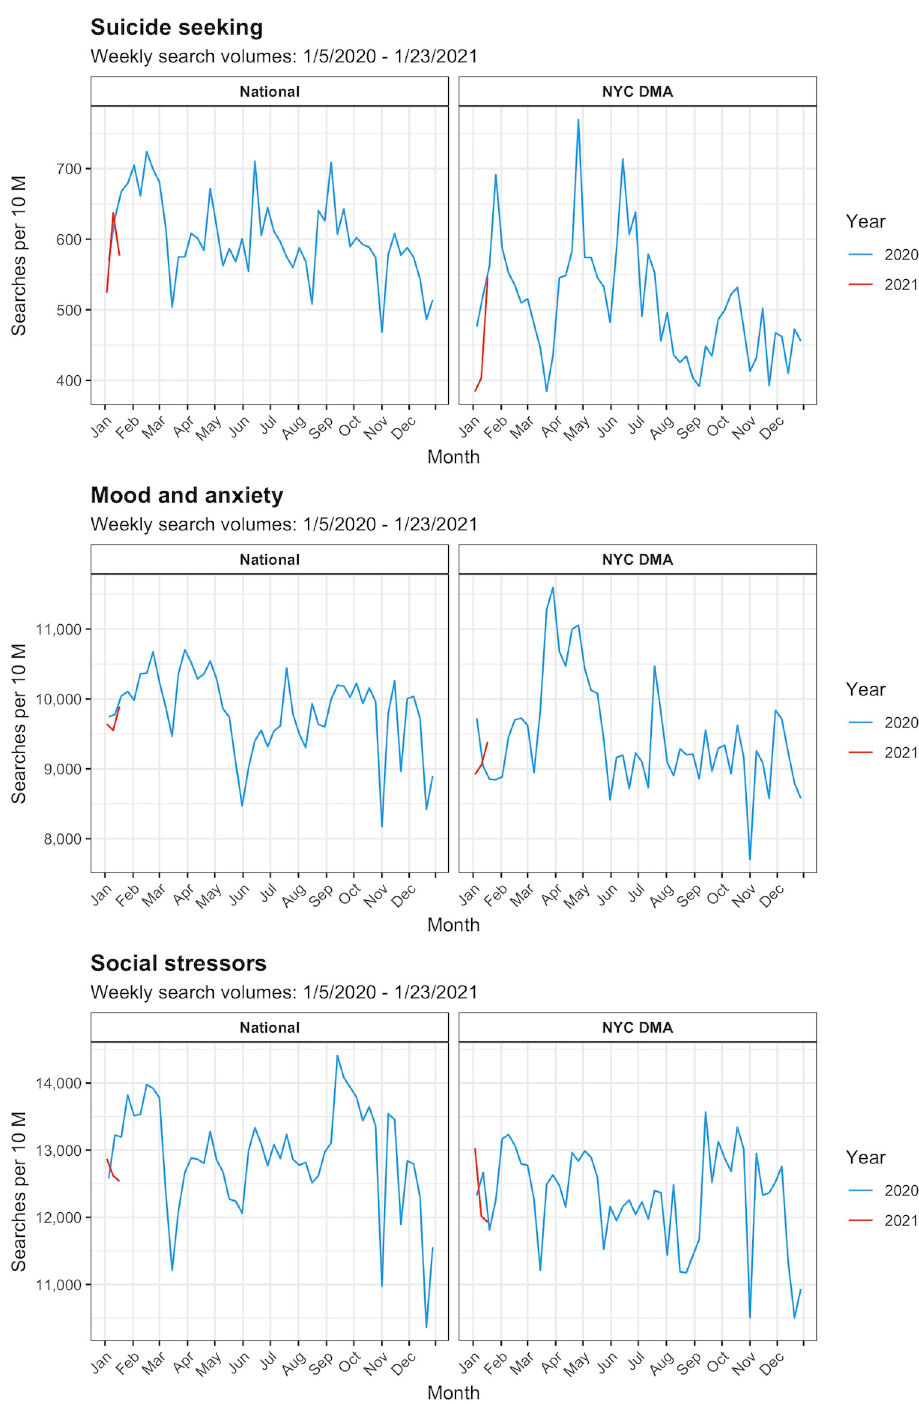
Fig 3. Google Health Trends search volumes for suicide seeking, mood and anxiety, and social stressor terms over time nationally and in the NYC DMA: 2020–2021.